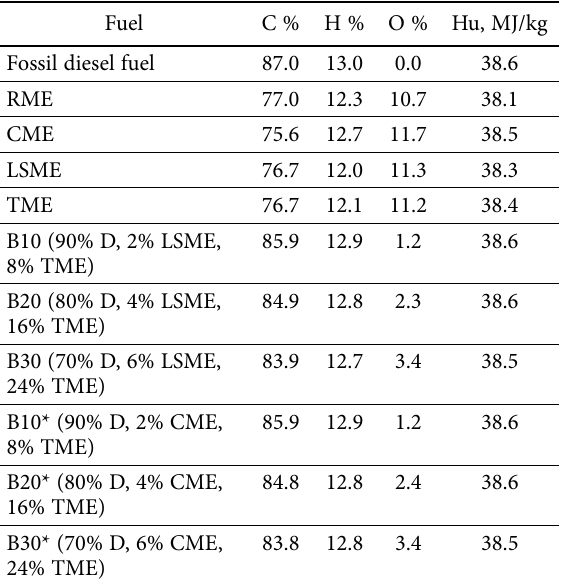
Table 2. The elemental composition of fuel Fuel